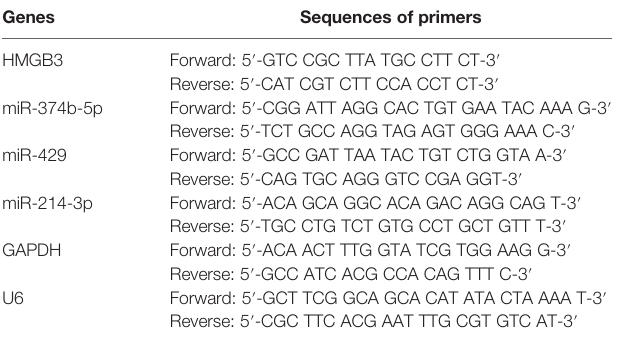
TABLE 1 | Primers used in